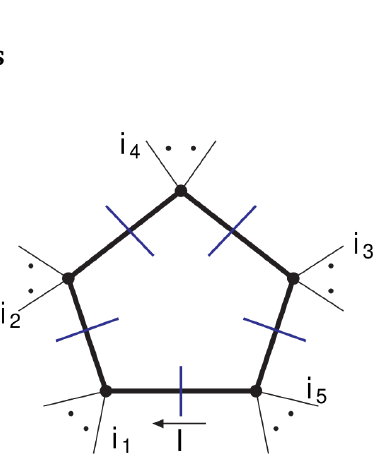
Figure 3: The five-particle cut reproduces pentagon